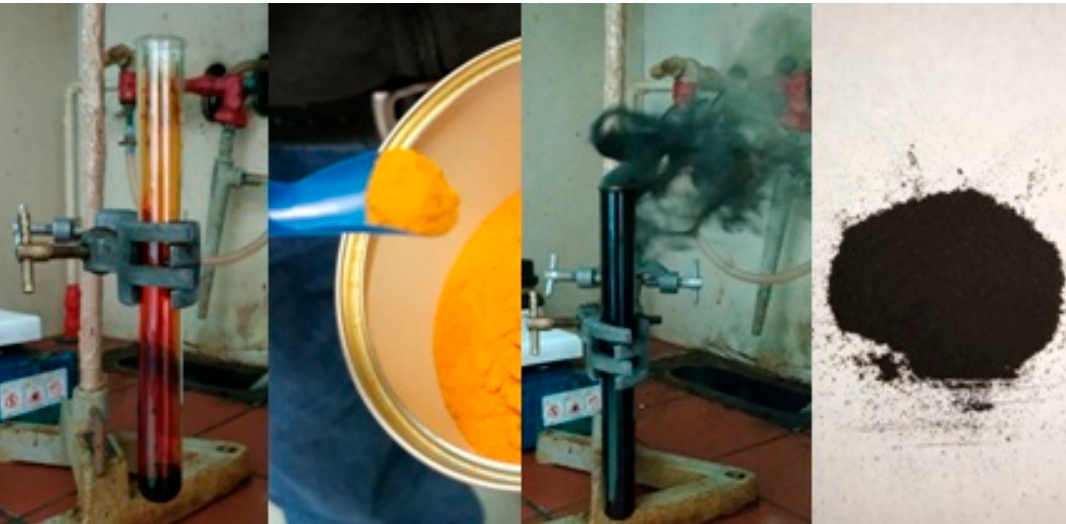
Figure 1. Addition of ferrocene to liquid bromine rapidly led to an exothermic reaction that released carbon soot partly deposited on the walls of the test tube. After collecting and washing the carbon residue, a fine black powder was obtained.